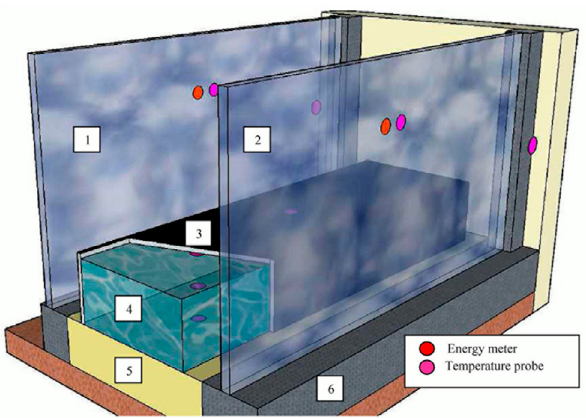
Figure 9. A schematic diagram of DGU containing PCM accumulator between the panes. 1—exterior glazing, 2—interior glazing, 3—thermal storage unit, 4—PCM, 5—XPS thermal insulation, 6—window frames [36].